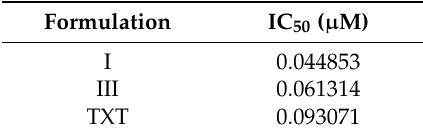
Table 4. IC 50 ( µ M) for formulations and TXT, on C-26 cell line after 72